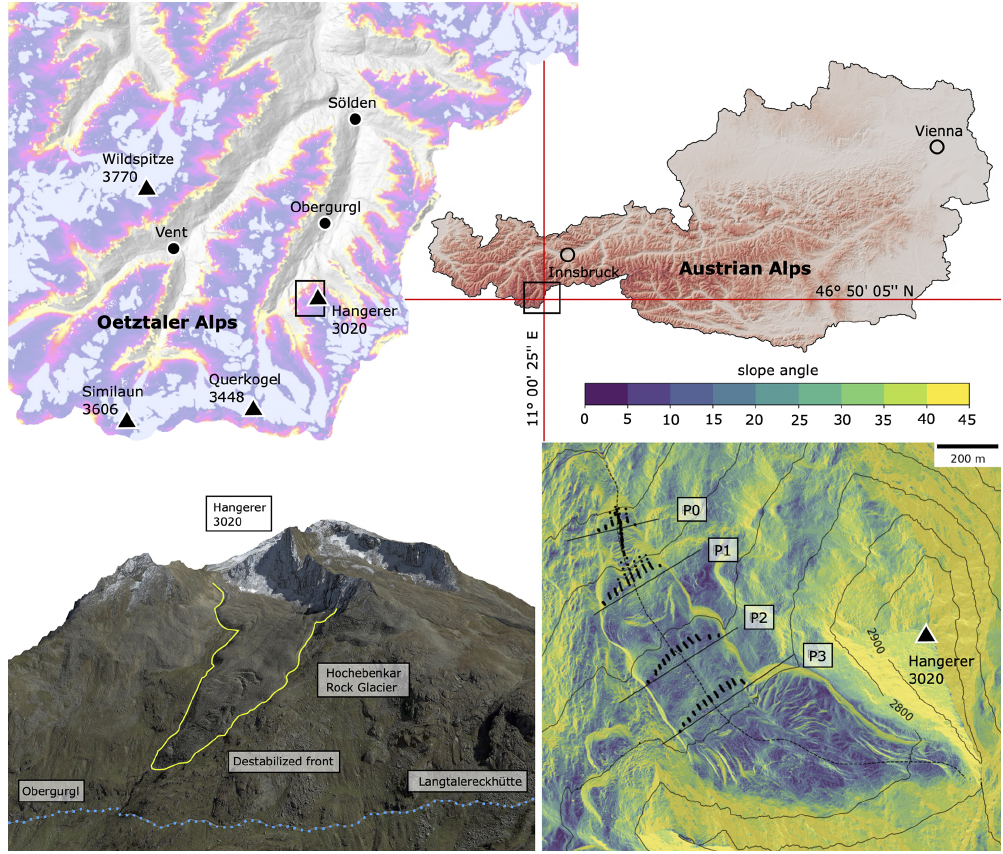
Figure 1. Location of the study area in the Austrian Alps (top right, red shading shows elevation; base data: NASA Shuttle Radar Topography Mission (SRTM)) and detail of the geographical context of the Hochebenkar rock glacier in the Ötztal Alps (top left; base data: SRTM): the overlay shows the permafrost index map as per Boeckli et al. (2012a), light blue indicates a glacier, dark blue indicates permafrost in nearly all conditions, purple indicates permafrost mostly in cold conditions, and yellow indicates permafrost only in very favourable conditions. A 3D visualization of the study site (bottom left; base data: SRTM and © Google Earth) and slope angle map draped over hillshade with contour lines, which have all been generated from the 2017 digital surface model (bottom right). Black dots mark the positions of the blocks in the four cross profiles and the longitudinal profile for 2015–2021. Also shown are the central flowline (dashed black line) and the lines between the fixed reference points that define the positions of the cross profiles (solid black